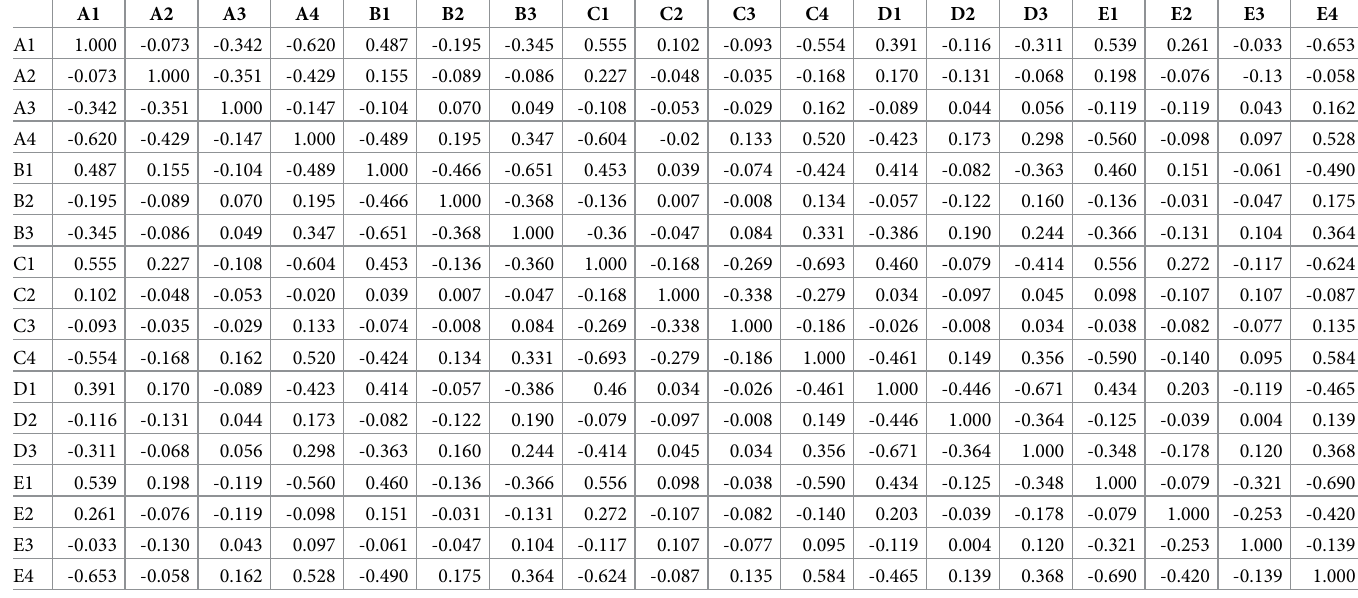
Table 5. Correlation matrix for estimates of element utility from best-worst scaling exercise. The entry for elements e and e ’ is ρ e,e 0 � .